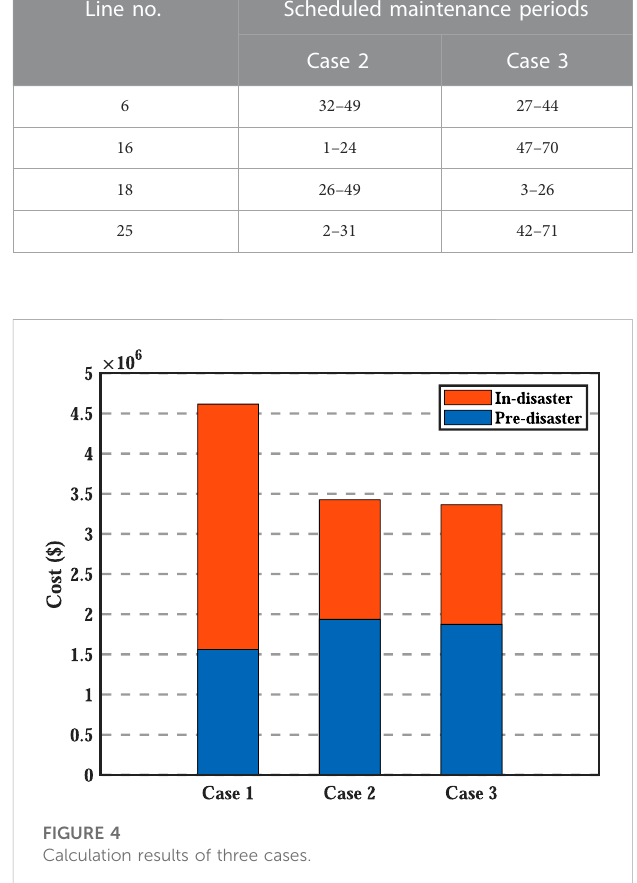
FIGURE 4 Calculation results of three